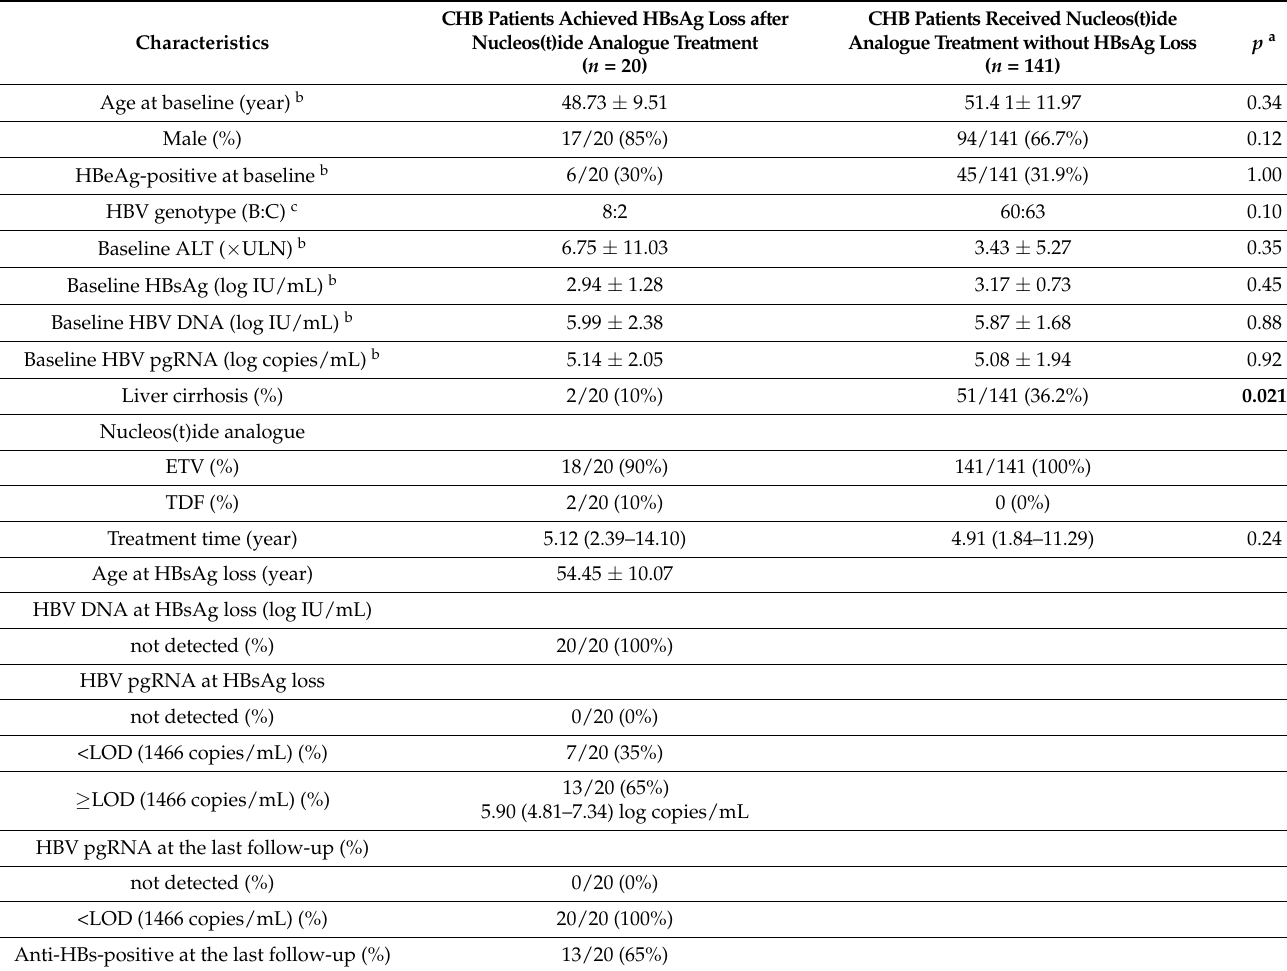
Table 3. Clinical characteristics of 20 chronic hepatitis B patients who achieved HBsAg loss after nucleos(t)ide analogue treatment and 141 chronic hepatitis B patients who received nucleos(t)ide analogue treatment without HBsAg loss for analyzing the factors associated with HBsAg